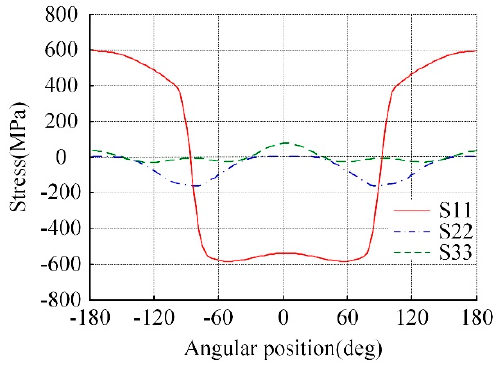
Figure 14. The stress of the inner surface of the pipe in different directions.